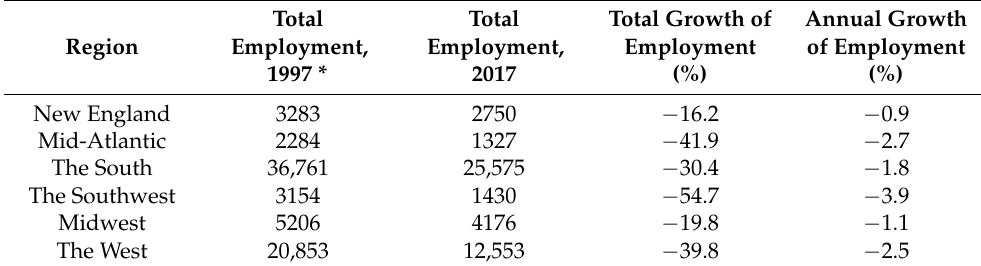
Table 1. Annual growth of employment in the logging industry from 1997 to 2017 [38].